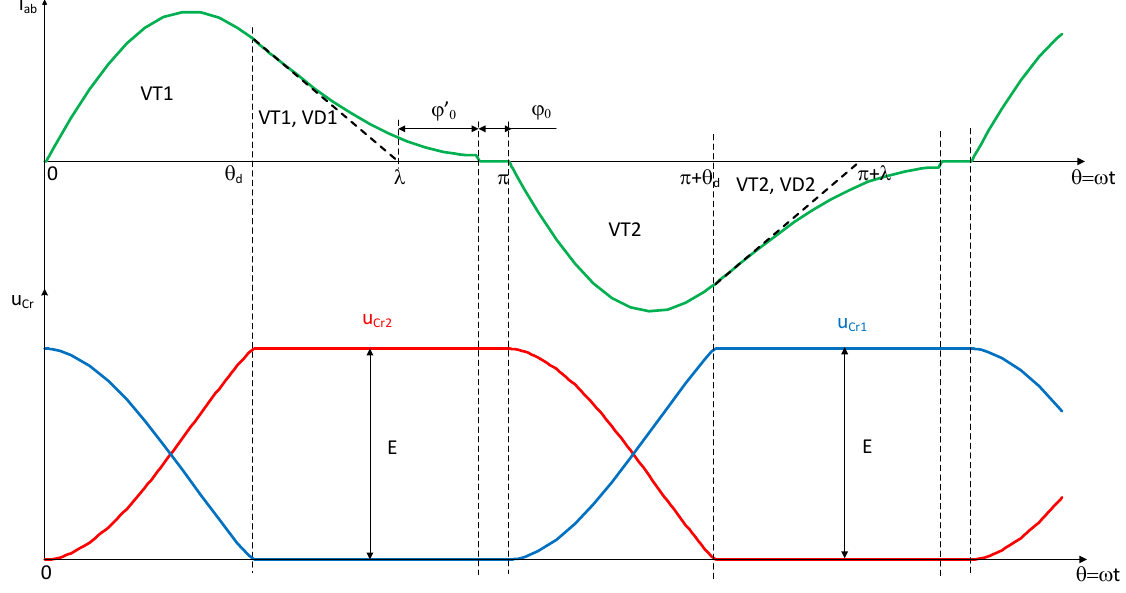
Figure 2. Timing diagrams in established operation mode of RI with ED and split resonance capacitor.